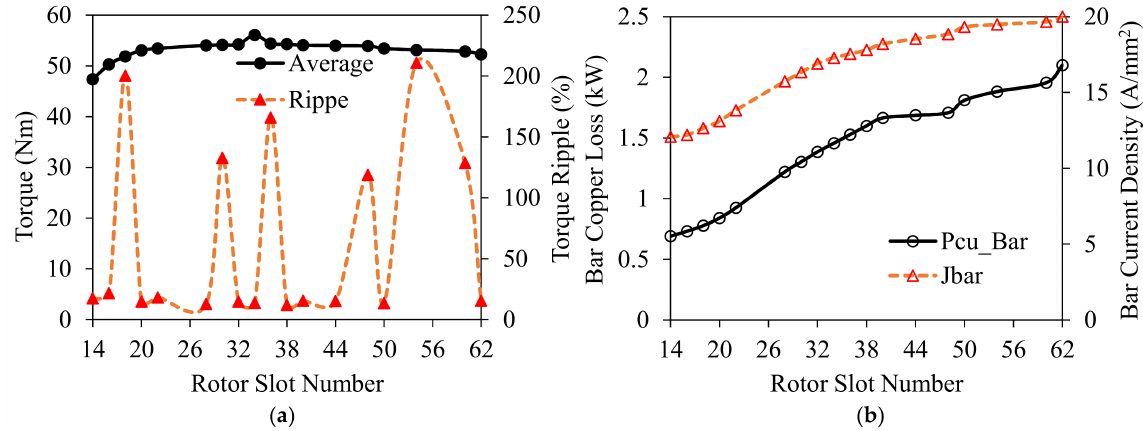
Figure 23. Influence of the rotor slot number on the performance characteristics of 18S/6P AIM: ( a ) torque and torque ripple and ( b ) bar copper loss and bar current density.